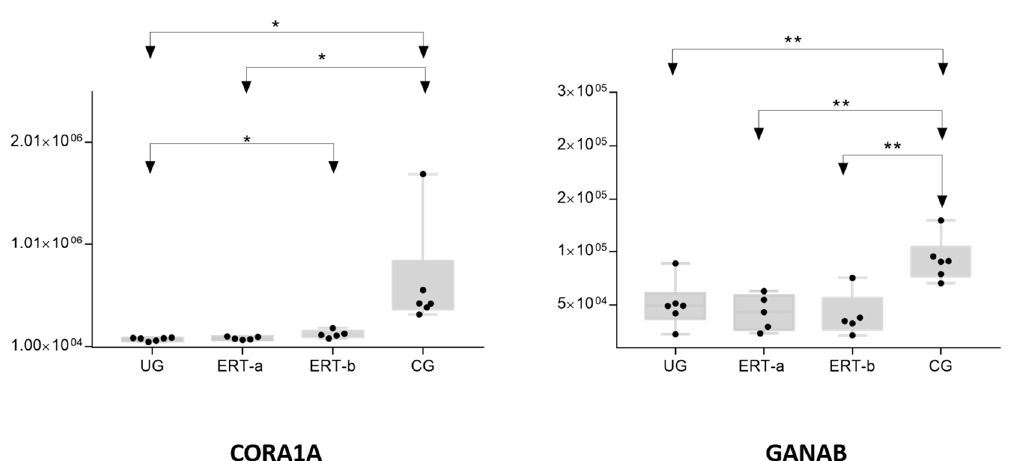
Figure 6. Changes in the levels of CORO1A and GANAB proteins in the different groups analyzed. Each point represents the mean value of the protein area for an individual sample in each group. The bottom and top of each box represent the first and third quartiles, respectively. The whiskers represent the minimum and maximum values within 1.5 times the interquartile range. Any data points not included between the whiskers are considered outliers. * p < 0.05; ** p < 0.01. Abbreviations: CG, control group; ERT-a: ERT-a, patients sampled before enzyme infusion; ERT-b, patients sampled 24 h after enzyme infusion; UG: untreated group.